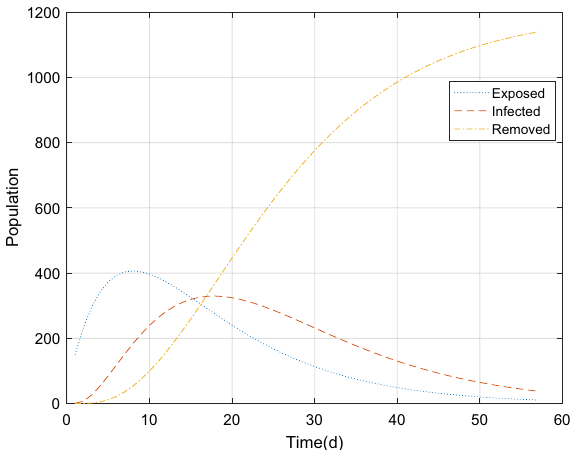
Figure 7. The population of exposed, infected and removed in Beijing Xinfadi over time.